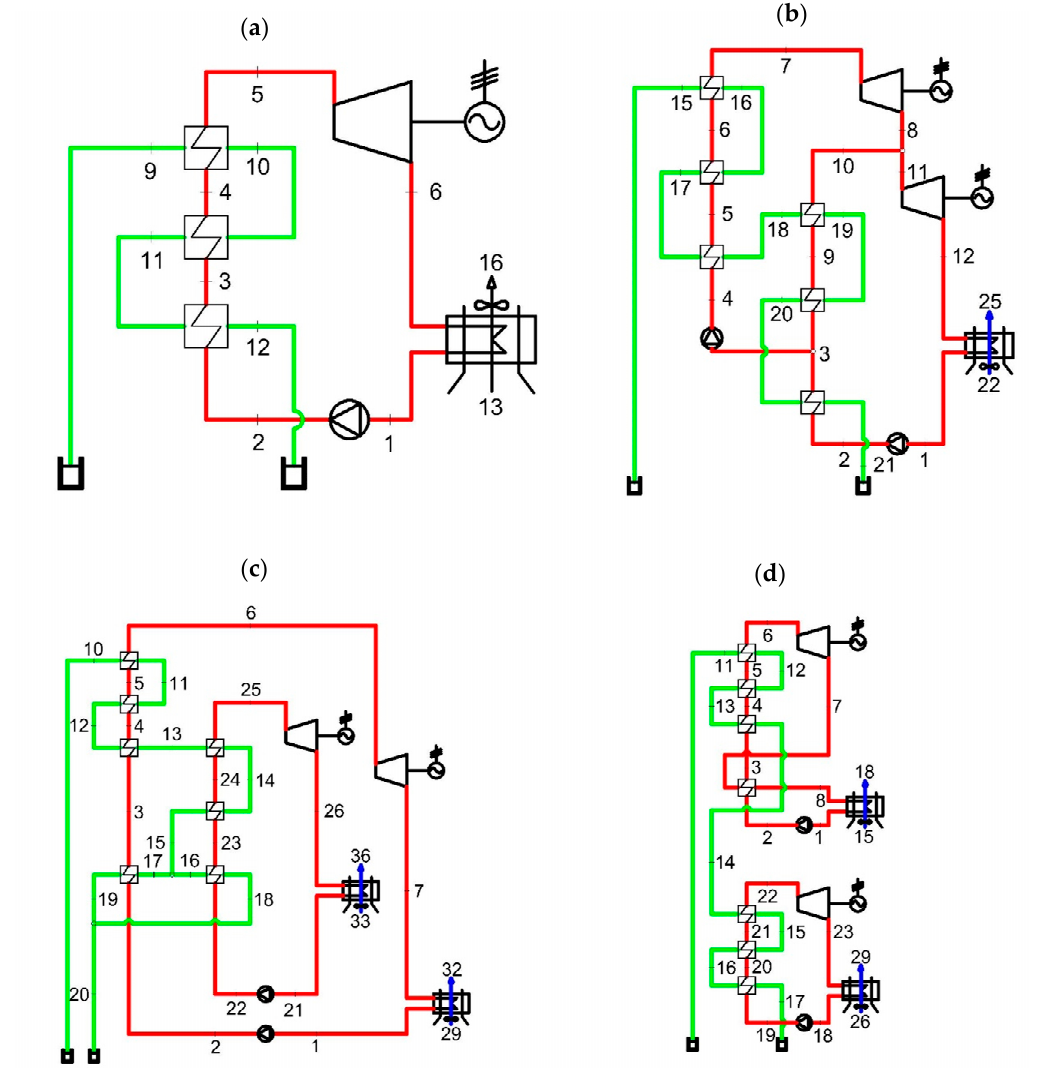
Figure 1. Analyzed ORC configurations: ( a ) SORC; ( b ) DPORC; ( c ) DS parHTSLTPH ORC; ( d ) DS HTSIHE ORC.